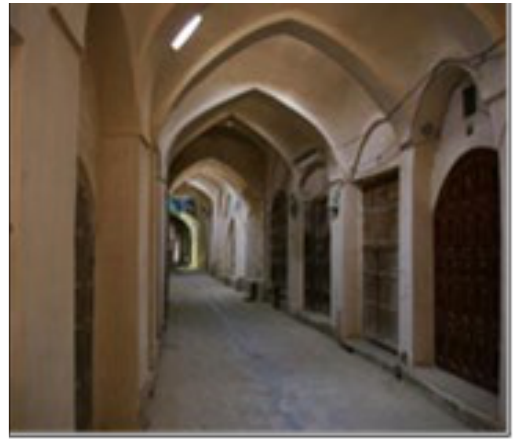
Fig. 13: The principle of symmetry, balance, rhythm in the design of walls